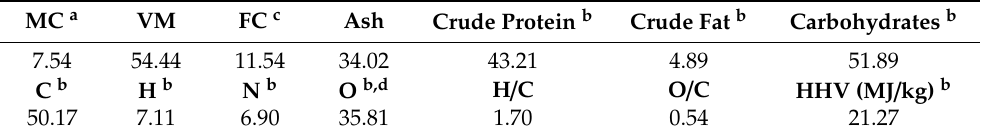
Table 1. Proximate and ultimate analysis (wt.%) of SS.